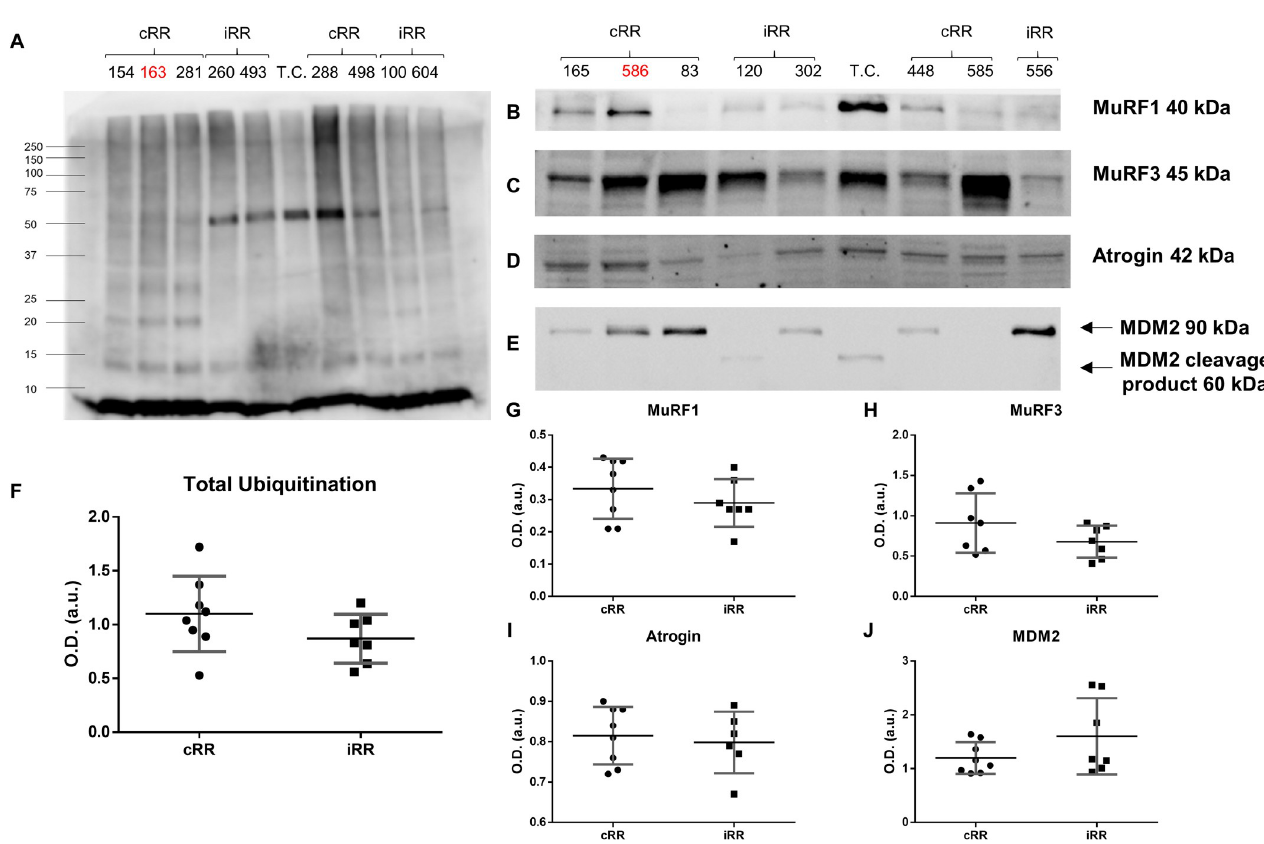
Fig 1. Myocardial ubiquitination profile and ubiquitin ligases expression in patients with complete or incomplete reverse remodeling. Representative western blot scans are depicted for ubiquitin-tagged proteins (A) and for the E3 ubiquitin ligases Muscle Ring Finger (MuRF) 1 (B), MuRF3 (C), atrogin-1 (D) and Murine Double Minute 2 (MDM2) (E). Additional blots can be found in S1 Fig. In the latter, two bands are identified with arrows, referring to intact MDM2 (upper arrow) and its cleavage product (lower arrow), as reported in the datasheet. Quantification was based on the intact band only. The respective optical density-based semi-quantification is shown in (F), (G), (H), (I) and (J). T.C. designates the technical control. Samples 163, 586 and 603 are marked in red because these were excluded from the study a posteriori (aortic or mitral insufficiency was found to be more or as severe as aortic stenosis). cRR identifies patients with complete reverse remodeling and iRR denotes patients with incomplete reverse